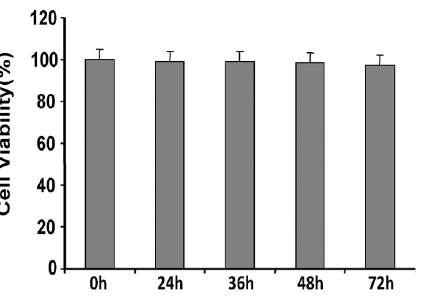
Figure 5. Effects of 2-AA on viability of mouse muscle cells. MTT assay measuring cell viability in mouse skeletal muscle cells (C2C12) after treatment with 0.8 mM 2-AA over time, as indicated in the figure. SDs (vertical bars) were calculated from three replicate